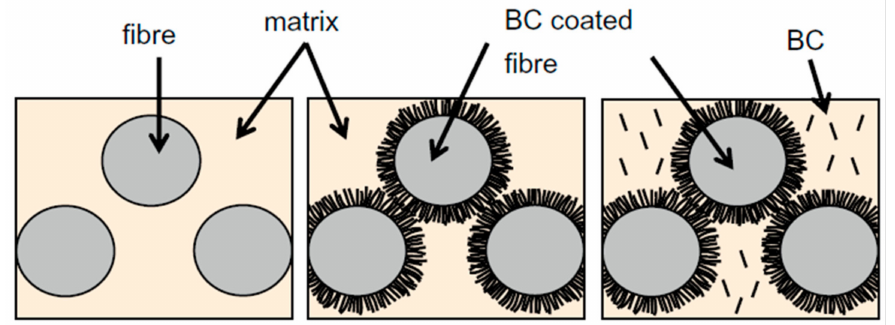
Figure 18. Illustration of the different hierarchical sisal fibres/PLA biocomposites with or without the addition of bacterial cellulose (BC). ( Left ) with untreated sisal fibres; ( middle ) with BC coated sisal fibres and ( right ) with BC coated sisal fibres and BC in the matrix bulk (reprinted from Lee et al., 2012